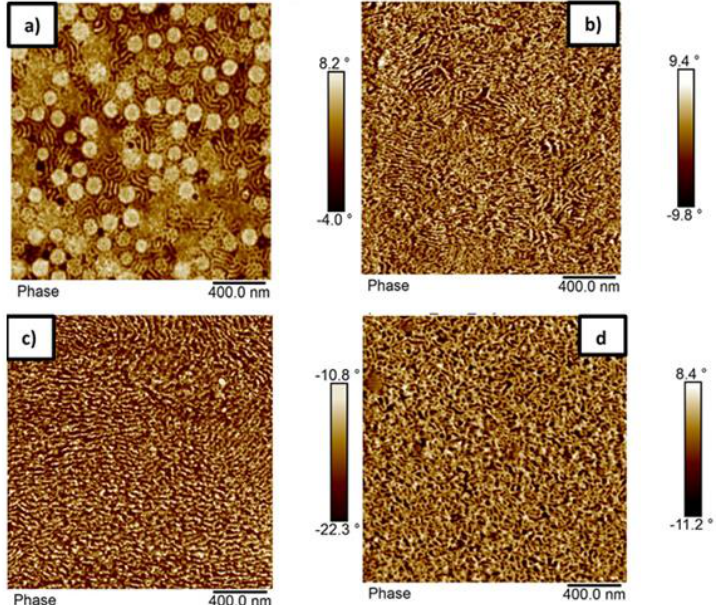
Figure 6. AFM phase images of the sample p(St15-2EHA50-St15): ( a ) top surface of the film dried at room temperature; ( b ) cross-section of the film dried at room temperature; ( c ) cross-section of the film dried at 100 °C, and; ( d ) cross section of a film cast from THF-solution.